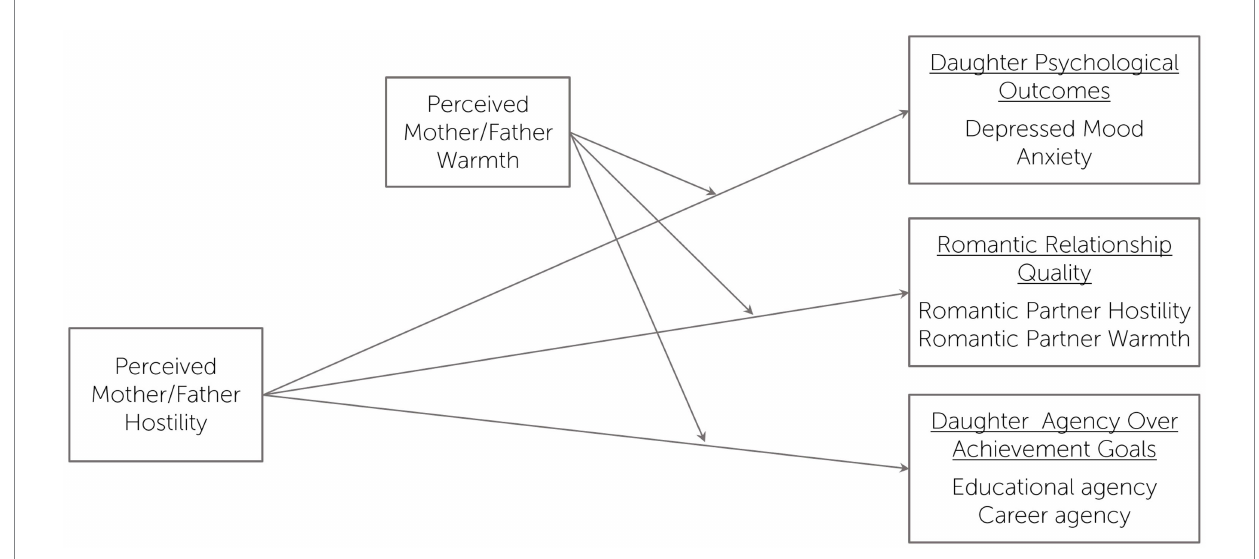
FIGURE 1 The hypothesized